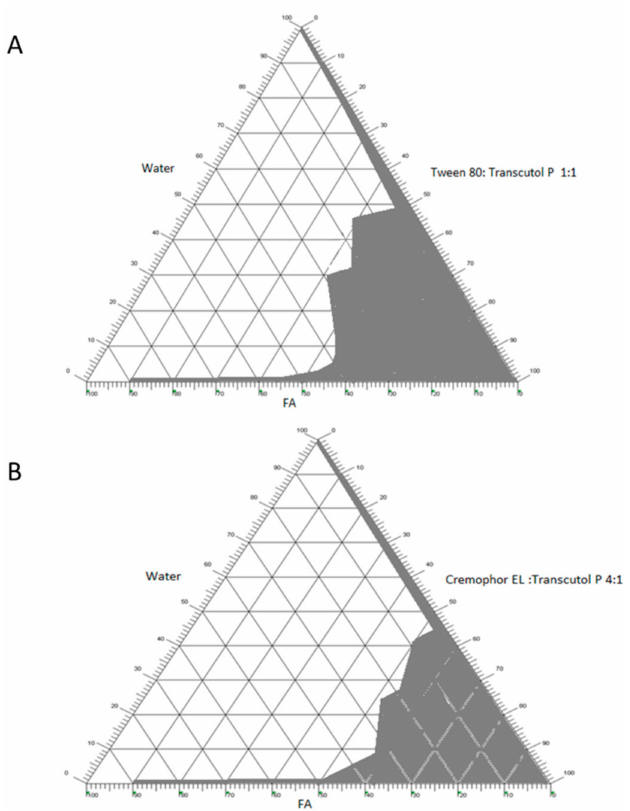
Figure 2. Pseudo-ternary phase diagrams of α -linolenic acid, water, surfactant/cosurfactant (S/CoS) mix made of ( A ) Tween 80/Transcutol P (1:1), ( B ) Cremophor EL/Transcutol P